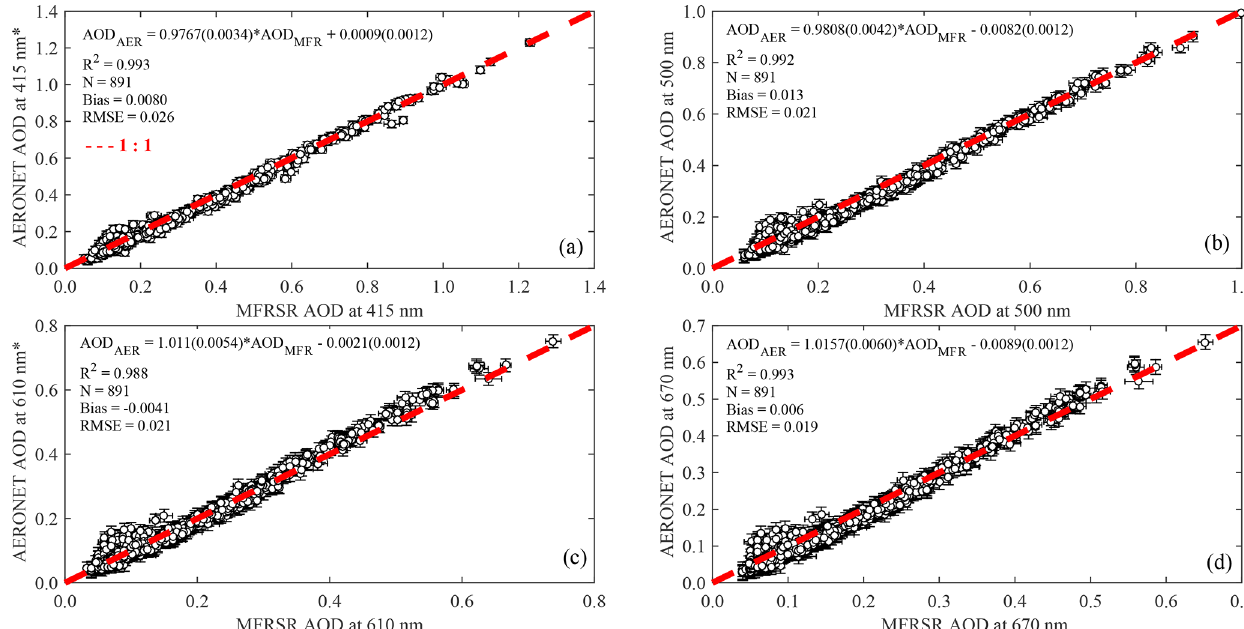
Figure 5. Spectral AOD retrieval from the on-site calibrated MFRSR as a function of AOD from the AERONET direct Sun product level 2.0 for 2012. The asterisk ( ∗ ) indicates that the AOD at that wavelength was estimated using the Ångström exponent and the dashed red line represents the 1 : 1